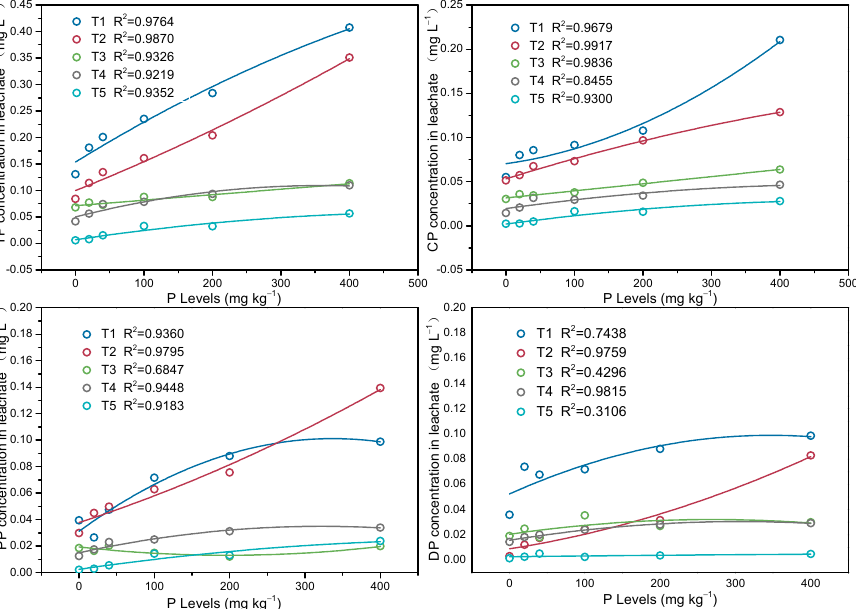
Figure 7. The relationship between total phosphorus (TP), colloidal phosphorus (CP), dissolved phosphorus (DP), and particle phosphorus (PP) in leachate and phosphorus (P) application levels after the soil columns were conducted at 7 days (T1), 14 days (T2), 21 days (T3), 28 days (T4), and 56 days (T5).